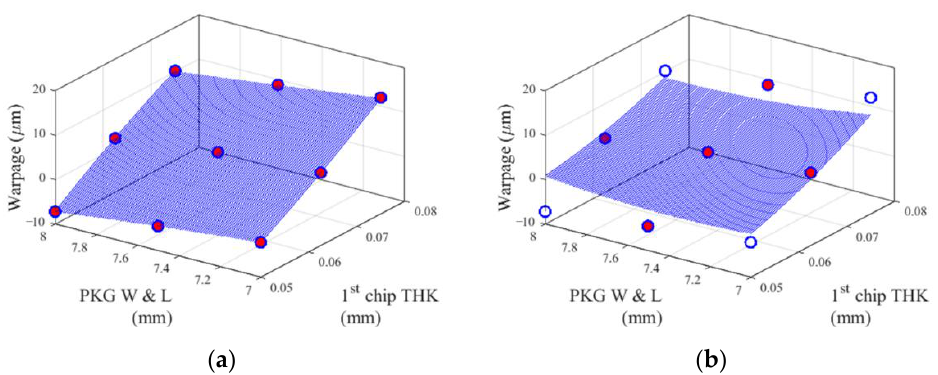
Figure 10. 2D performance functions of design variables of ( a ) Bivariate Cut HDMR and ( b )